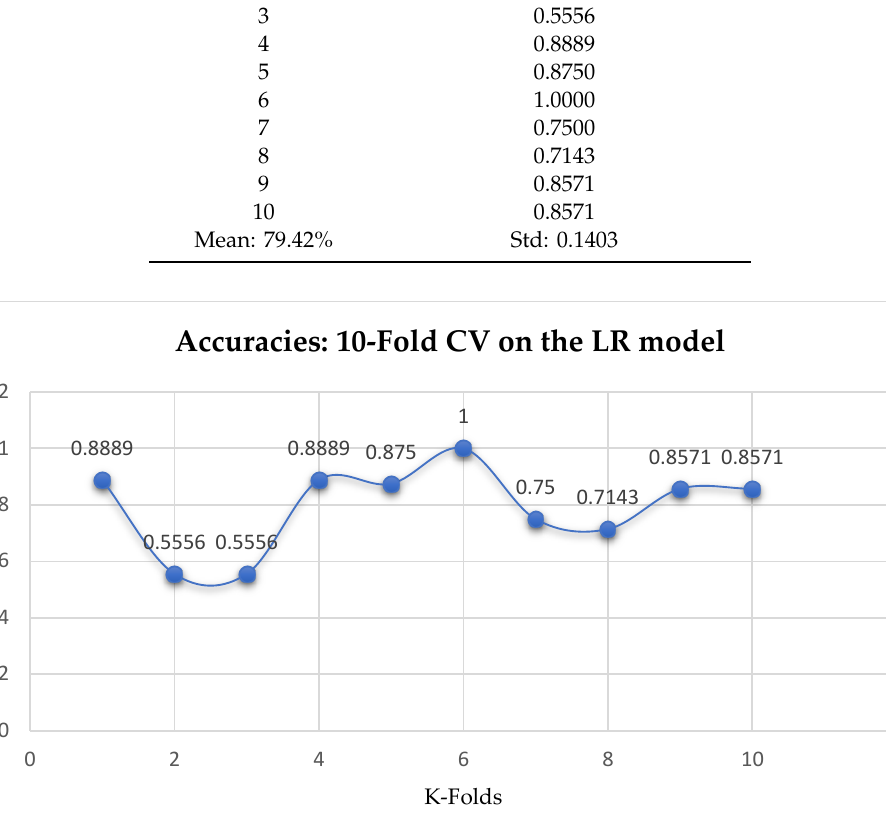
Figure 16. The accuracies achieved by the Folds after performing 10-Fold Cross-Validation on the LR model.